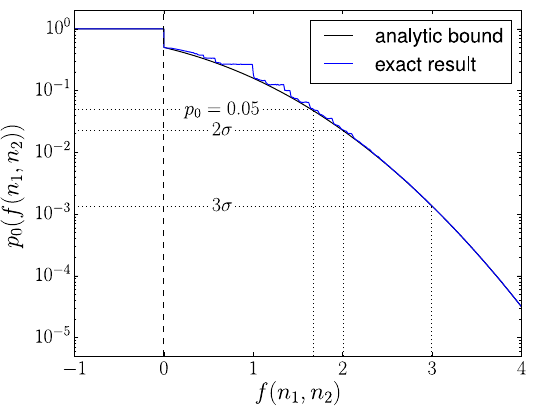
Figure 3. The p -value, de(cid:12)ned in (3.1), plotted as a function of the statistic f ( n 1 ; n 2 ). Also shown is the lower bound (3.3) to which the p -value converges for large values of the